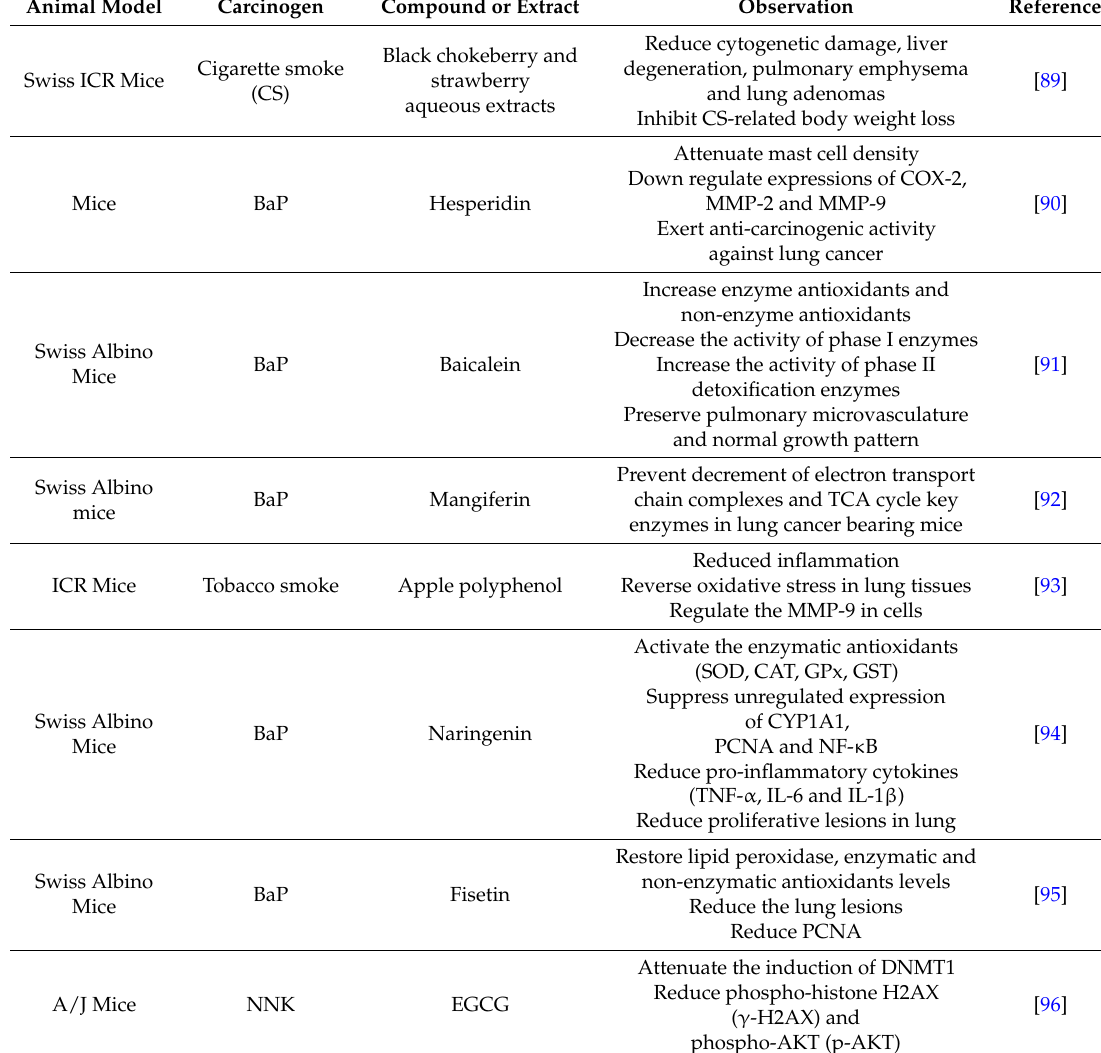
Table 3. Polyphenols in cancer prevention: in vivo